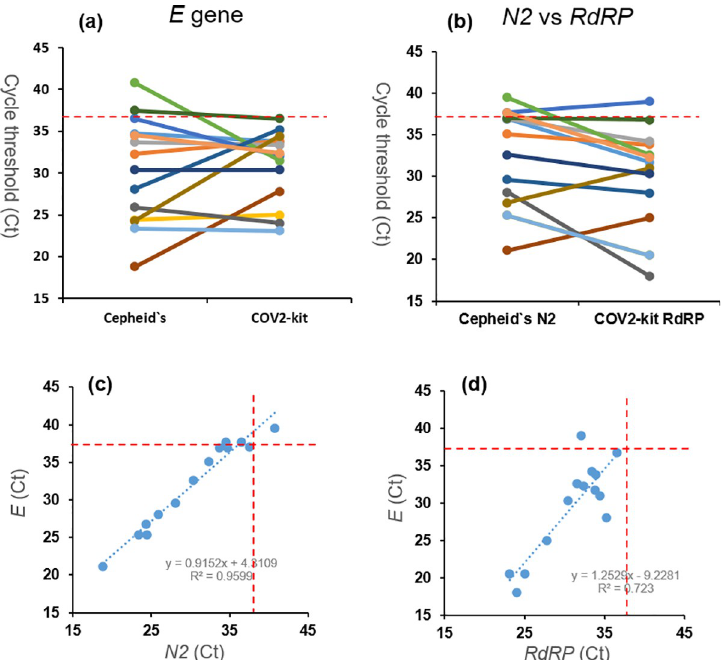
Fig 3. Comparison of the cycle threshold (Ct) value of COVID-19 positive samples using Cepheid‘s and the current (COV2-kit) assays. (a) The data shows the Ct value of E gene, which is the common gene in both assays. (b) The comparison of Cepheid‘s N2 and COV2-kit‘s RdRP genes. The plots show the comparison of Ct values of the target genes for (c) Cepheid‘s E and N2 ; and (d) COV2-kit‘s RdRP and E . The red dashed line shows threshold value of 37, which is accepted as the upper limit for SARS-CoV-2 detection by